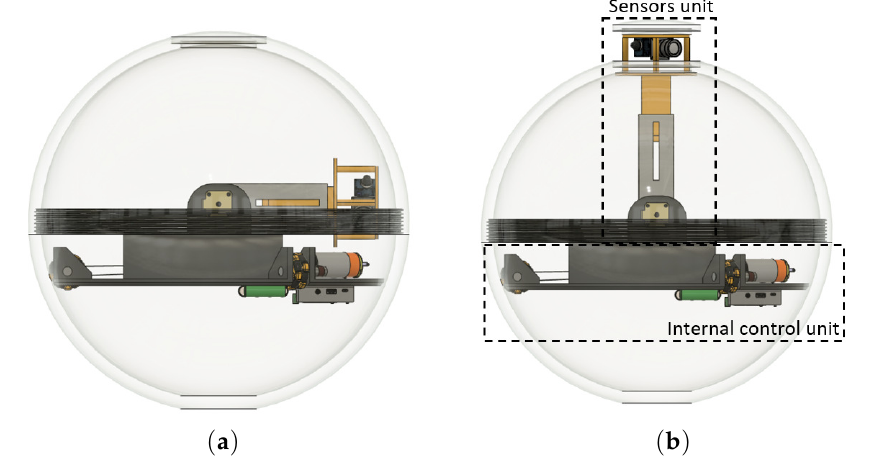
Figure 11. Modes of our SR. ( a ) Rolling mode. ( b ) Measuring